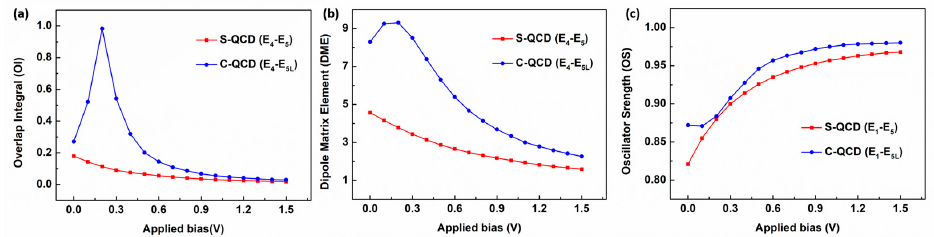
Figure 6. Correlations between different energy levels. ( a ) OI and ( b ) DME over the applied bias between the excited state (E 5 ) and extractor energy level (E 4 ). ( c ) Oscillator strength between the ground state (E 1 ) and excited state (E 5 ).